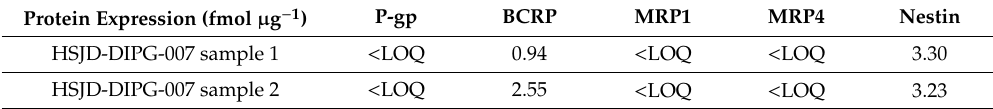
Figure 3. P-glycoprtoein (P-gp) ( A ), Bcrp ( B ), and Mrp1 ( C ) expression levels in whole homogenates from the cortex, cerebellum, and brainstem of control sham vs. DIPG-bearing rats, measured by HPLC-MS / MS of 8-week-old RH-Foxn1rnu nude rats. Results are expressed as the mean absolute concentration (fmol µ g − 1 ) ( n = 5 animals per group). Two-way ANOVA, no statistical di ff erence between groups was observed ( p > 0.05), regardless of the brain structure analyzed for any of the ATP-binding cassette (ABC) transporters measured (i.e. P-gp, Bcrp, Mrp1). Table 1. Expression of selected ABC transporters in HSJD-DIPG-007 cells, measured by HPLC-MS / MS. Results are expressed as the mean absolute concentration (fmol µ g − 1 ) of duplicate measurements ( n =